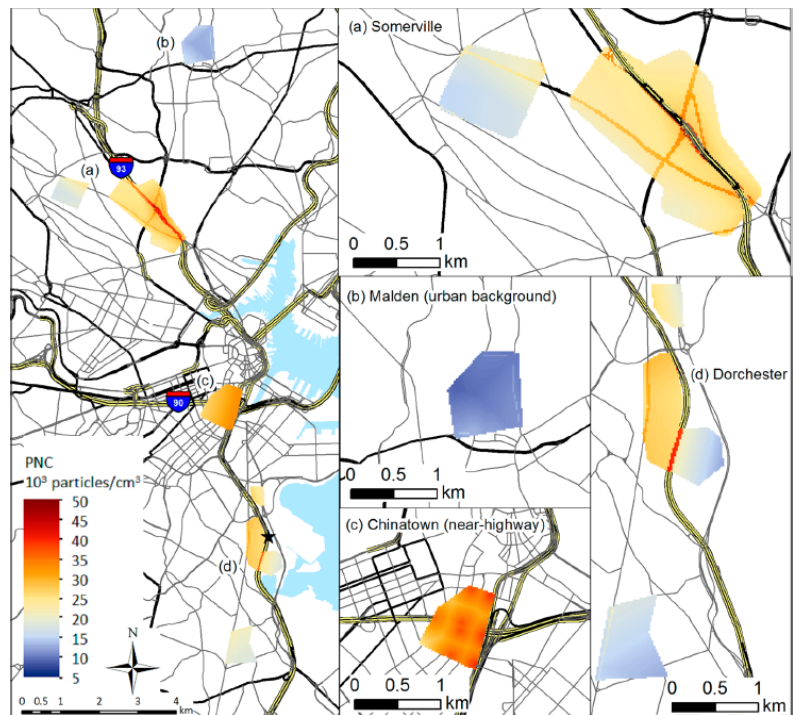
Figure 2. Ultrafine particle (UFP) level maps. The Community Assessment of Freeway Exposure and Health (CAFEH) study conducted mobile air pollution monitoring in three sets of paired neighborhoods, near the highway and >1 km from the highway (listed as (a), (b), (c), (d) on the map). UFP were measured as particle number count using a condensation particle counter. The data from the mobile monitoring were used to develop land use regression (LUR) models of particle number count (or PNC, a measure of ultrafine particles) for each of the study areas. The LUR models had a resolution of 20 m and 1 hour. The hourly estimates of PNC level were then averaged over a year to calculate the annual average values that are plotted in this figure.